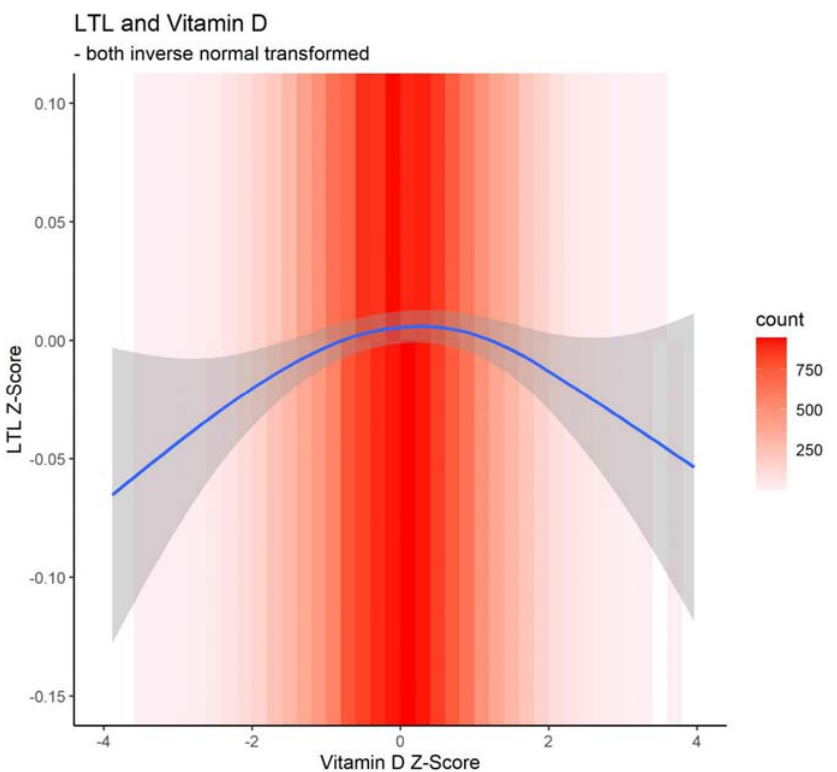
Figure 1. Flowchart of the final analytical sample. Figure 2. Relationship of z-transformed leukocyte telomere length versus z-transformed vitamin D (curve plotted based on the generalized additive model including a cubic regression spline with